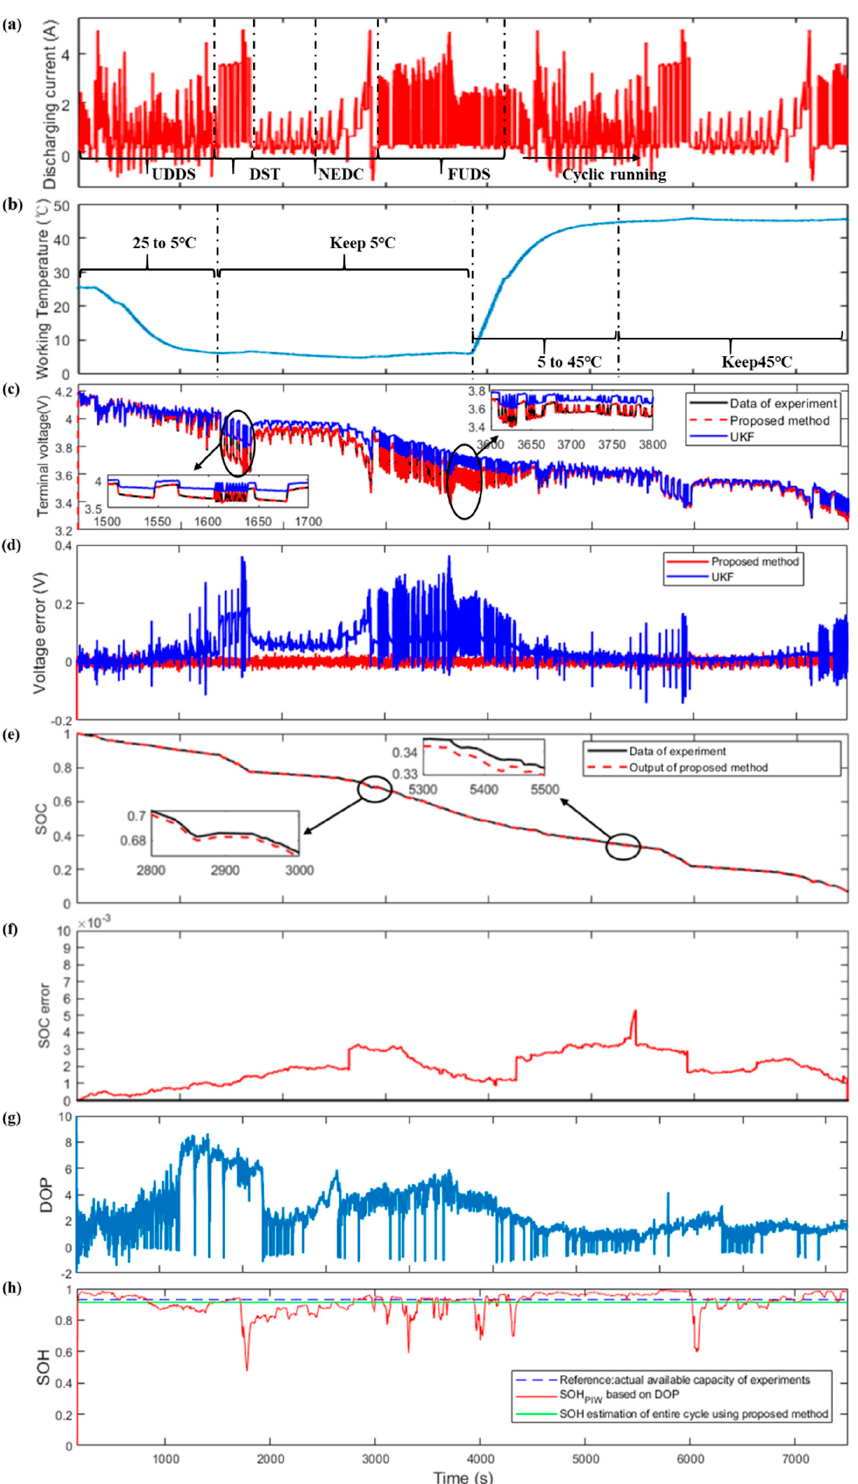
Figure 10. Estimation results of the variable temperature combined operating condition test. ( a ) Operating current profile combined by Urban Dynamometer Driving Schedule (UDDS), Dynamic Stress Test (DST), NEDC, and Federal Urban Driving Schedule (FUDS); ( b ) working temperature profile shifting between 5–45 ℃ ; ( c ) output terminal voltages; ( d ) terminal voltages error; ( e ) estimated SOC; ( f ) SOC error; ( g ) DOP-SOC curve; and ( h ) Estimated SOH PIW and estimated SOH of entire cycle.